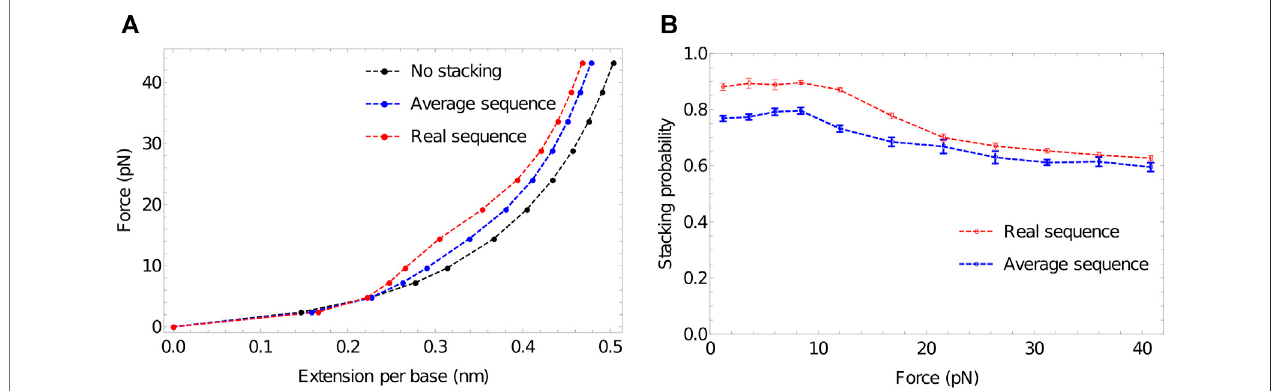
FIGURE 6 | The response of ssDNA to tension, and the role of stacking therein. (A) Force-extension plots for 100-nucleotide poly (dA) using three models: no stacking(black);averagestackingstrength(oxDNA1.0,blue)andsequence-dependentstacking(oxDNA1.5,red).Strongerstackingleadstoanincreasedforceatlarger extensions, and extremely strong stacking results in a plateau-like feature as stacking is disrupted. (B) Stacking probability for average stacking strength (oxDNA1.0, blue)andsequence-dependentstacking(oxDNA1.5,red)asafunctionofappliedforce.Adjacentnucleotidesarede fi nedasstackedifthestackingenergybetween the pair is more than -0.1